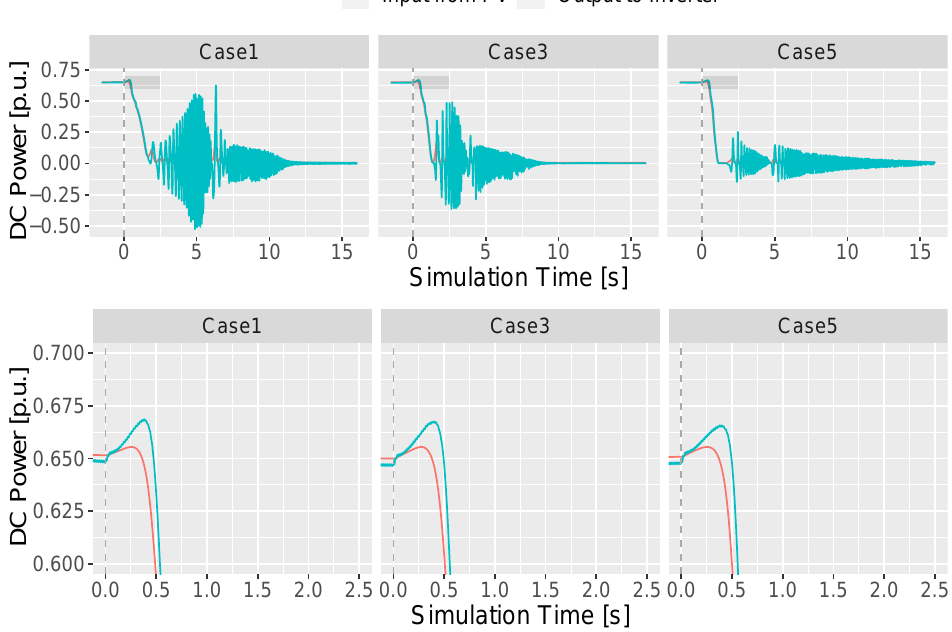
Figure 9. Active power flow of the DC/DC converter in the unstable cases: Case1, Case3, and Case5. The figures in the bottom row shows a zoomed-in view of the instant of load